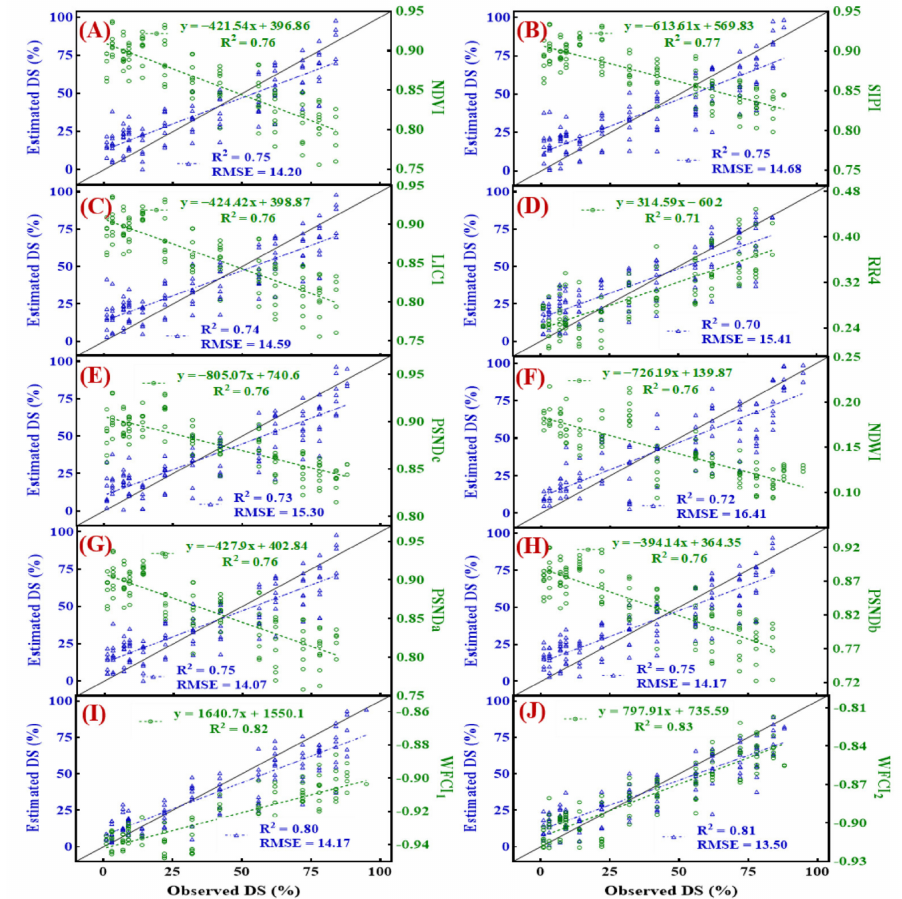
Figure 9. Illustration of univariate quantitative relationship among spectral vegetation indices (VIs) and disease severity (DS): ( A – J ) Right Y -axis (feature data points — green circles) and X -axis (disease severity) are scatter plots of corresponding features using datasets of the first year (2020), on the basis of which disease estimation model equations (Eqs)—plotting linear curve in univariate simple regression—are developed; ( A – J ) left Y -axis (estimated DS — blue triangles) and X -axis (observed DS) are 1:1 cross-validations of Eqs for each corresponding feature, using datasets of the second year (2021). ( A ): Normalized difference vegetation index (NDVI); ( B ): structure-intensive pigment index (SIPI); ( C ): Lichtenthaler index (LIC1); ( D ): Simple Ratio (RR4); ( E ): pigment specific normalized difference index (PSNDc); ( F ): normalized difference water index (NDWI); ( G , H ): pigment specific normalized difference indices (PSNDa and PSNDb); ( I , J ): wheat fusarium canopy indices (WFCI 1 and WFCI 2 ) (the reader is referred to the article’s web version for interpreting—colored references in figure